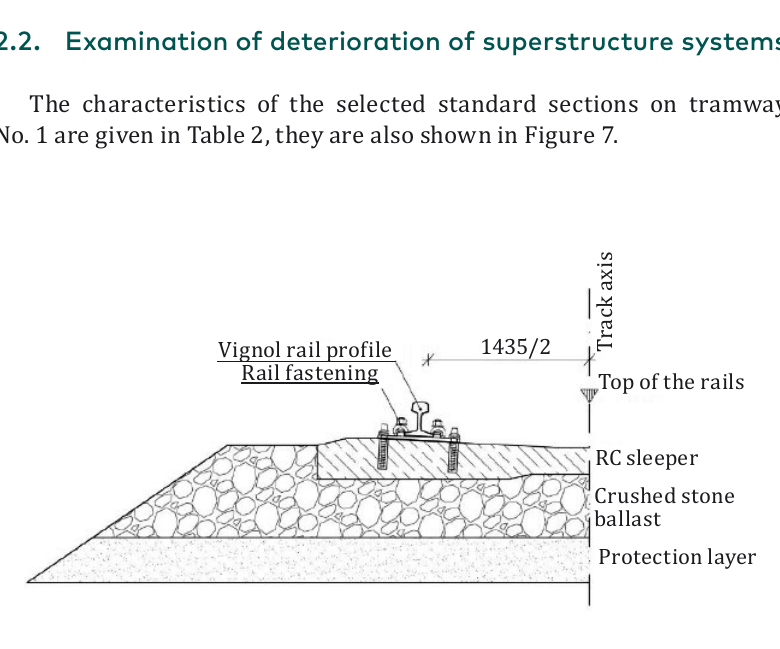
Figure 6. Cross-section of the ballasted track (BKV Zrt., 2019) Table 1. Characteristics of vehicles (BKV Zrt,